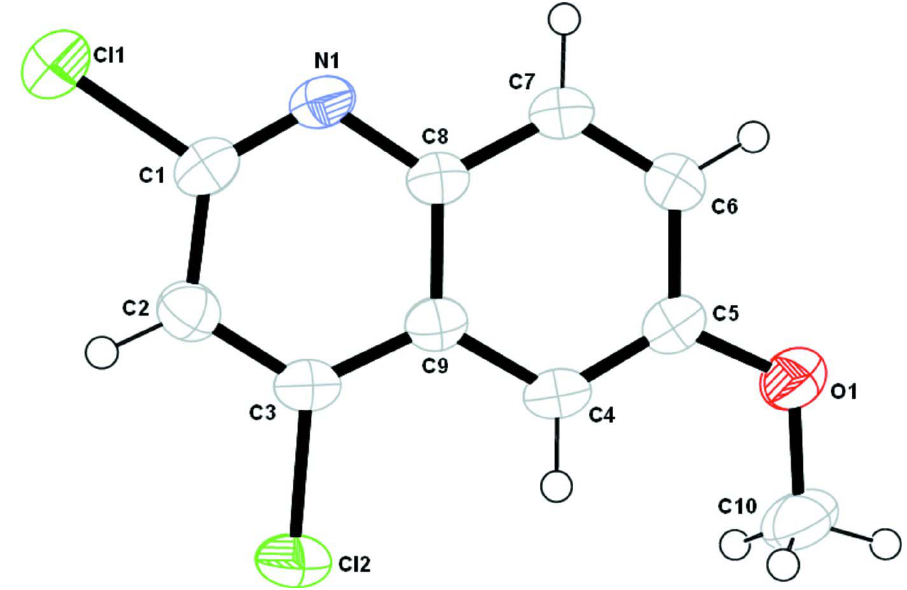
Figure 1 ORTEP diagram of the title compound with 50% probability displacement